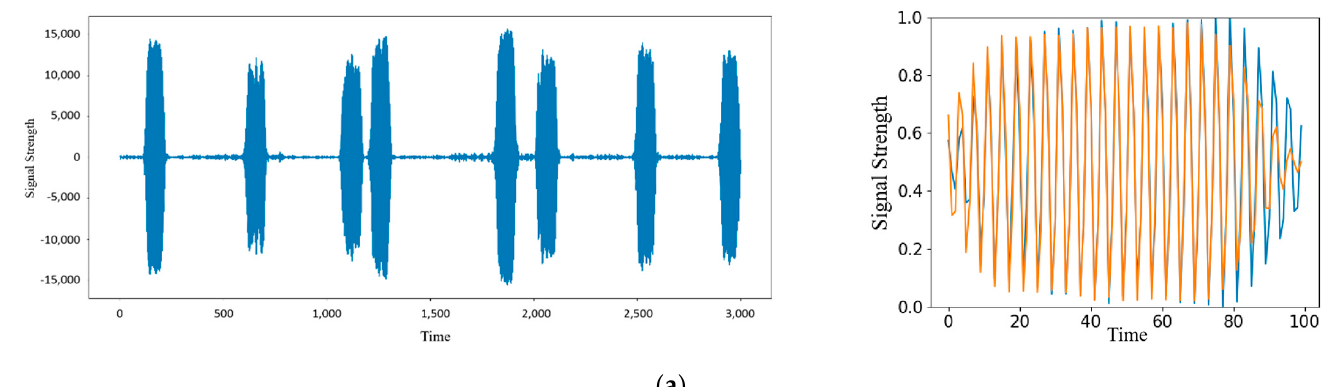
Figure 11. Complexity analysis of common anomaly detection models.